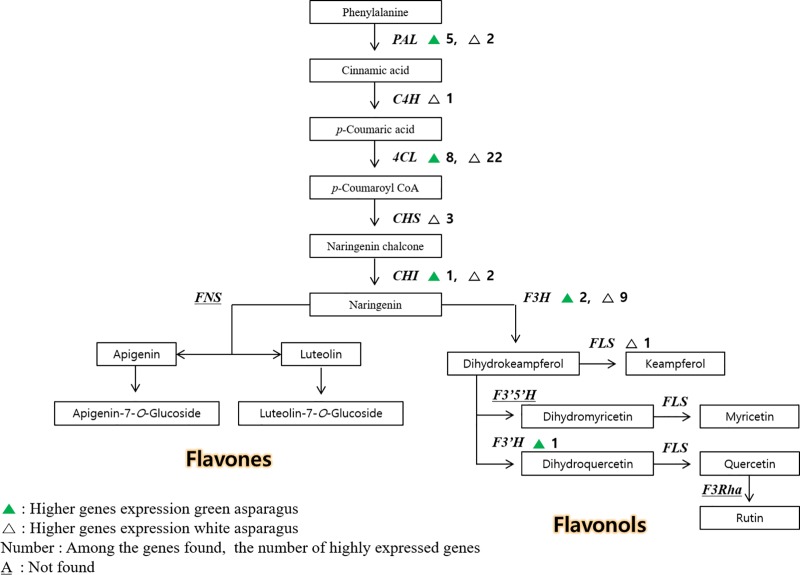
Biosynthetic pathways and compartmentalization of flavonoid synthesis in plants.4CL, 4-coumarate:CoA ligase; C4H, cinnamate-4-hydroxylase; CHS, chalcone synthase; CHI, chalcone isomerase; F3H, flavanone 3-hydroxylase; F3′H, flavonoid 3′-hydroxylase; F3′5′H, flavonoid 3′,5′-hydroxylase; F3Rha, flavonol-3-O-glucoside l-rhamnosyltransferase; FLS, flavonol synthase; FNS, flavone synthase; PAL, phenylalanine ammonia-lyase. The numbering of the 3′, 4′, and 5′ carbon positions is shown in the structure. Enzyme names are in italics.